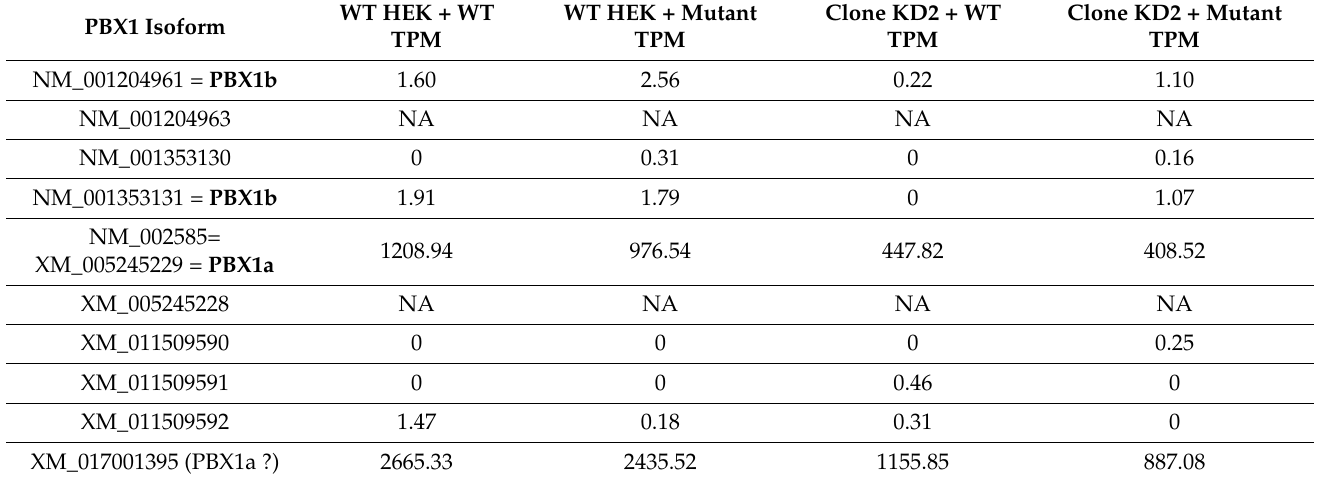
Table 1. PBX1 isoforms expressed in transfected cells. WT HEK+WT/mutant: WT HEK cells transfected with WT or mutant PBX1a plasmid. Clone KD2 + WT/mutant: KD2 cells transfected with WT or mutant PBX1a plasmid. TPM: transcript per million.